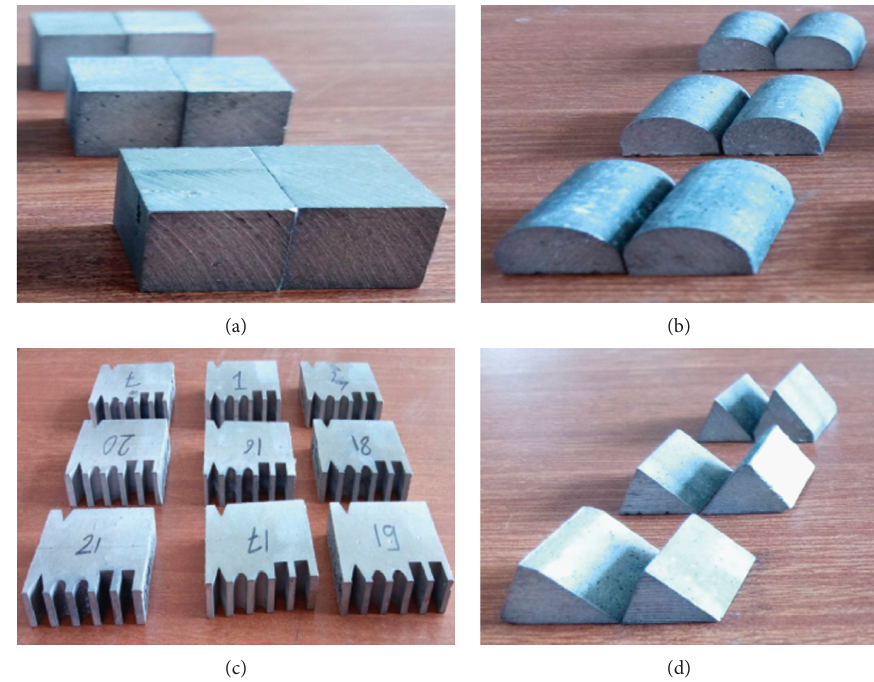
Figure 6: Al/Sic work piece components during different cutting.